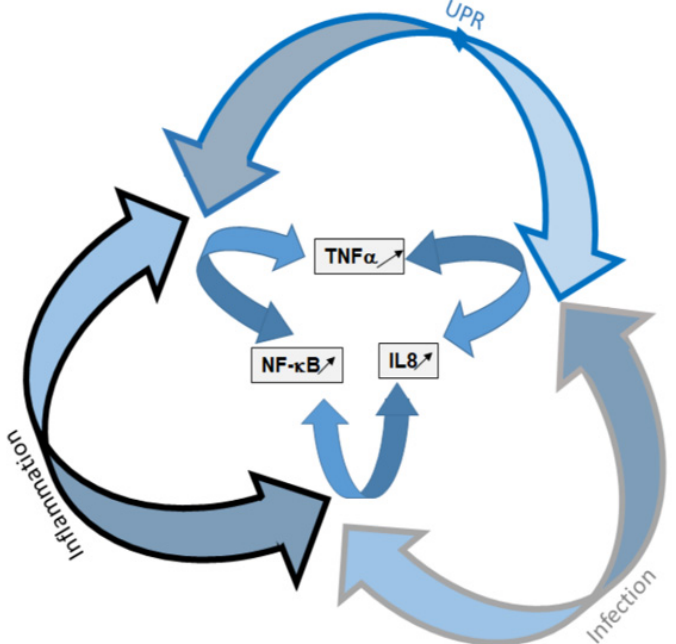
Figure 6. Schematic representation of the UPR, infection and inflammation interplay. UPR and its components are presented in blue, infection is in gray and inflammation in black. The three arms of the UPR are involved in the triggering of inflammation and infection. The three pathways share common elements that are mainly NF- κ B, TNF- α and IL-8.